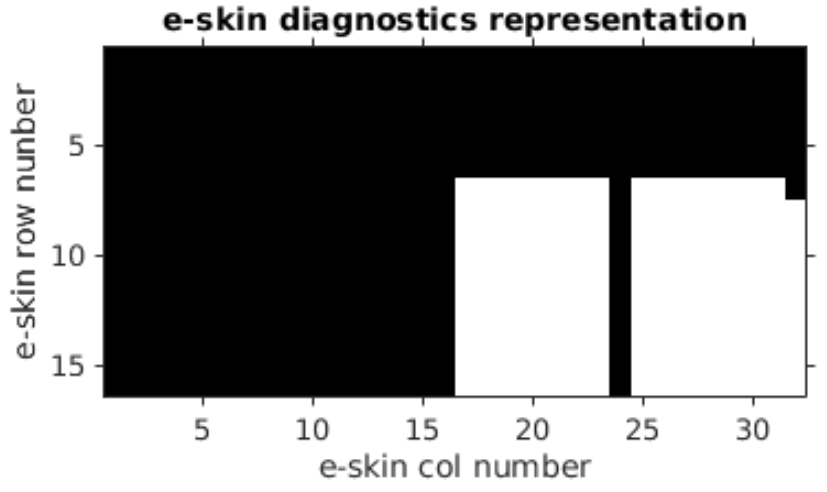
Figure 8. Diagnostic matrix—white squares indicate sensors for which valid data were collected. The e-skin subset being analysed—rows, 7–16; columns, 15–32. Entire columns 15, 16, 24 and the sensors (R7, C32) were found to be not working properly.